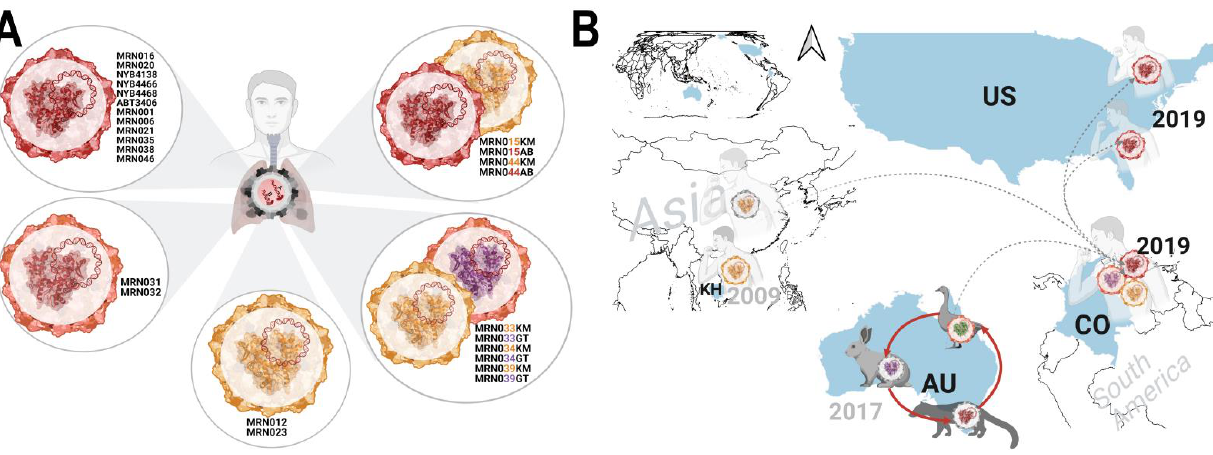
Figure 6. Respiratory PBV strains circulating in the Western Hemisphere originated from Asia and animal reservoirs. ( A ) Patient IDs are listed adjacent to capsid/RdRp combinations (single or dual infections) following the same color scheme in Figure 4. ( B ) PBV strains from Asia have traveled to South America and onward to North America. The ABT3406 index case and related strains may have arisen from an enzootic cycle in Australia between grey teal ducks, Tasmanian devils, and rabbits.